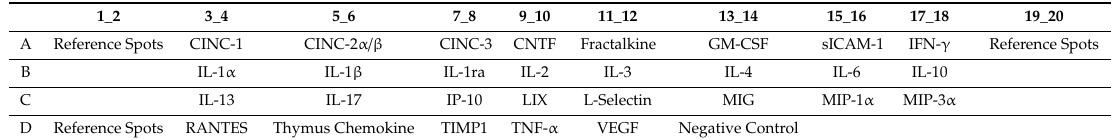
Table A1. Scheme of the rat cytokine antibody arrays used in the work. Rat Cytokine Array Panel A, 29 analyzed cytokines